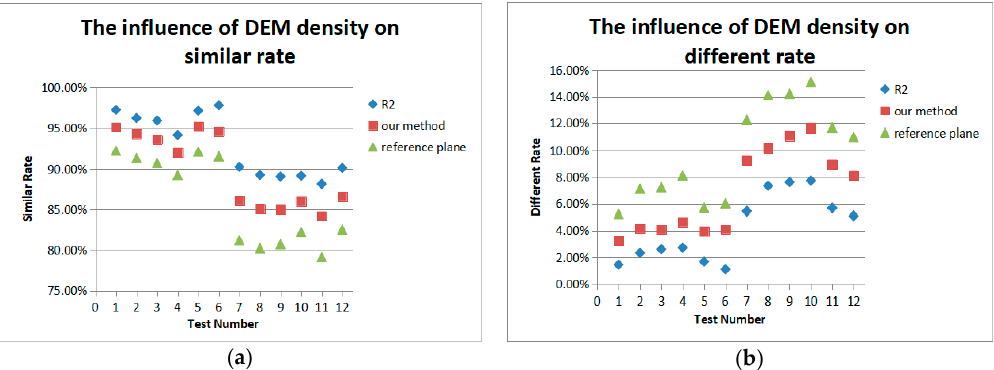
Figure 21. The influence of DEM resolution on the algorithms: ( a ) influence of DEM resolution on the different rate of each algorithm; and ( b ) influence of DEM resolution on the different rate of each algorithm.